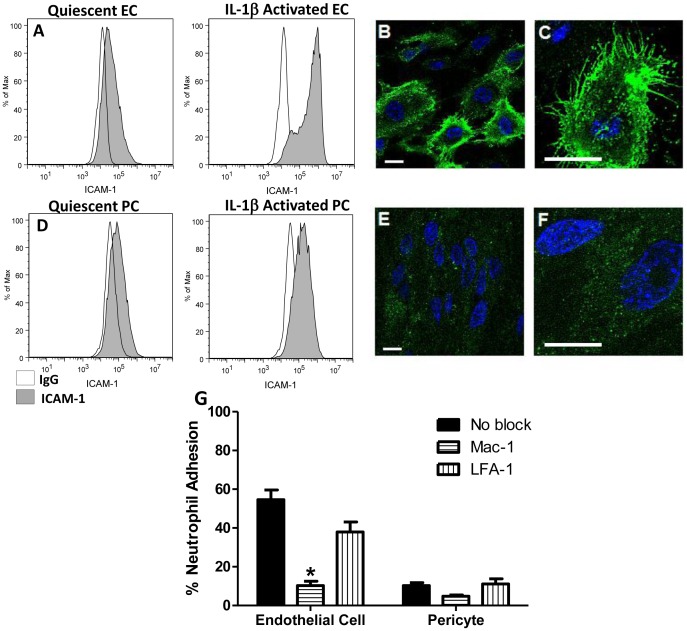
EC and PC ICAM-1 expression and effects of CD18 blocking on neutrophil adhesion.ICAM-1 expression on (A) EC or (D) PC monolayers before and after 4 hr IL-1β activation was assessed by flow cytometry (IgG labeled control white). ICAM-1 expression on (B,C) EC and (E,F) PC following 4 hr IL-1β activation was imaged using confocal microscopy. Scale bars are 20 µm. (G) Neutrophil adhesion inhibition to IL-1β activated EC or PC monolayers. Freshly isolated neutrophils were pre-incubated with anti-Mac-1 or anti-LFA-1 antibodies and seeded onto EC or PC monolayers (activated for 4 with IL-1β) in Sykes-Moore chambers and allowed to adhere prior to counting. Bars represent average neutrophil adhesion ± SEM. *P<0.05, when compared to the no block control.